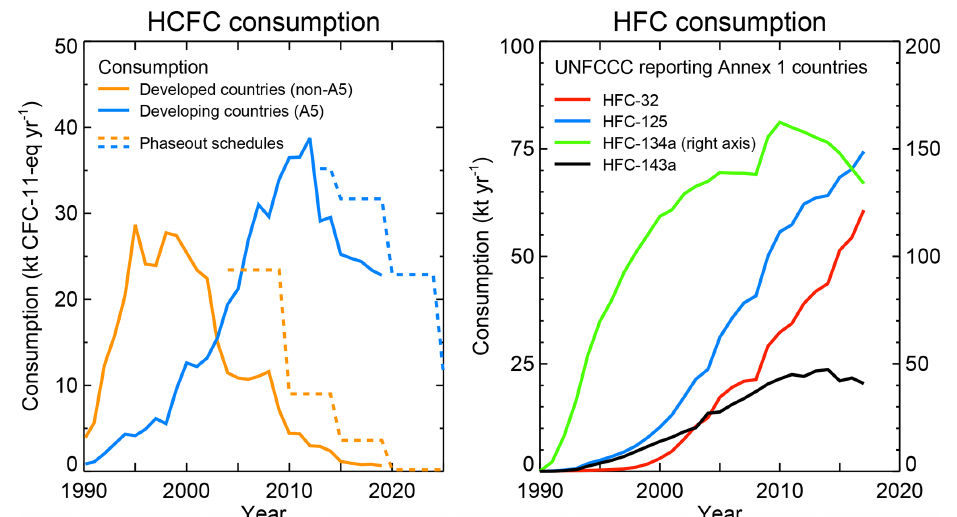
Figure 3. The left panel shows the HCFC consumption (ktCFC-11-eqyr − 1 ) in developed (non-A5) and developing (A5) countries as reported to UNEP (2021) and the Montreal Protocol phaseout schedules. The right panel shows the HFC consumption (ktyr − 1 ) in developed countries (Annex 1 countries) derived from the data reported to the UNFCCC